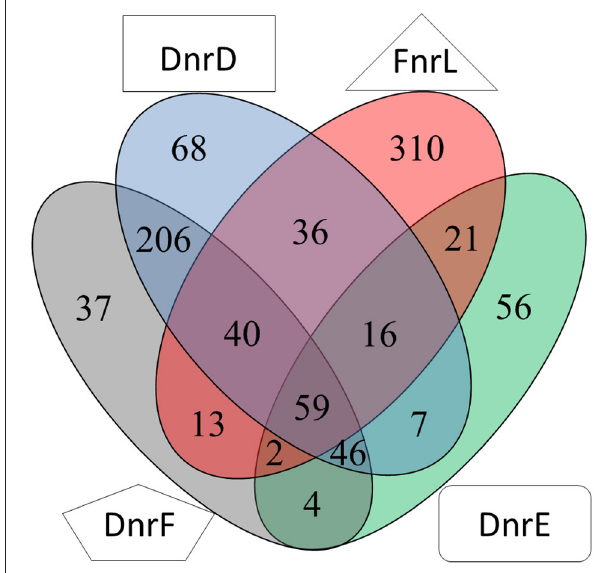
FIGURE 9 | Venn diagram of the overlapping regulons of Fnr, DnrD, DnrE and DnrF derived from transcriptional profiling experiments. Numbers for differentially expressed genes regulated by indicated regulators determined by transcriptome analyses using mutants of the corresponding regulator genes compared for aerobic vs. anaerobic growth are